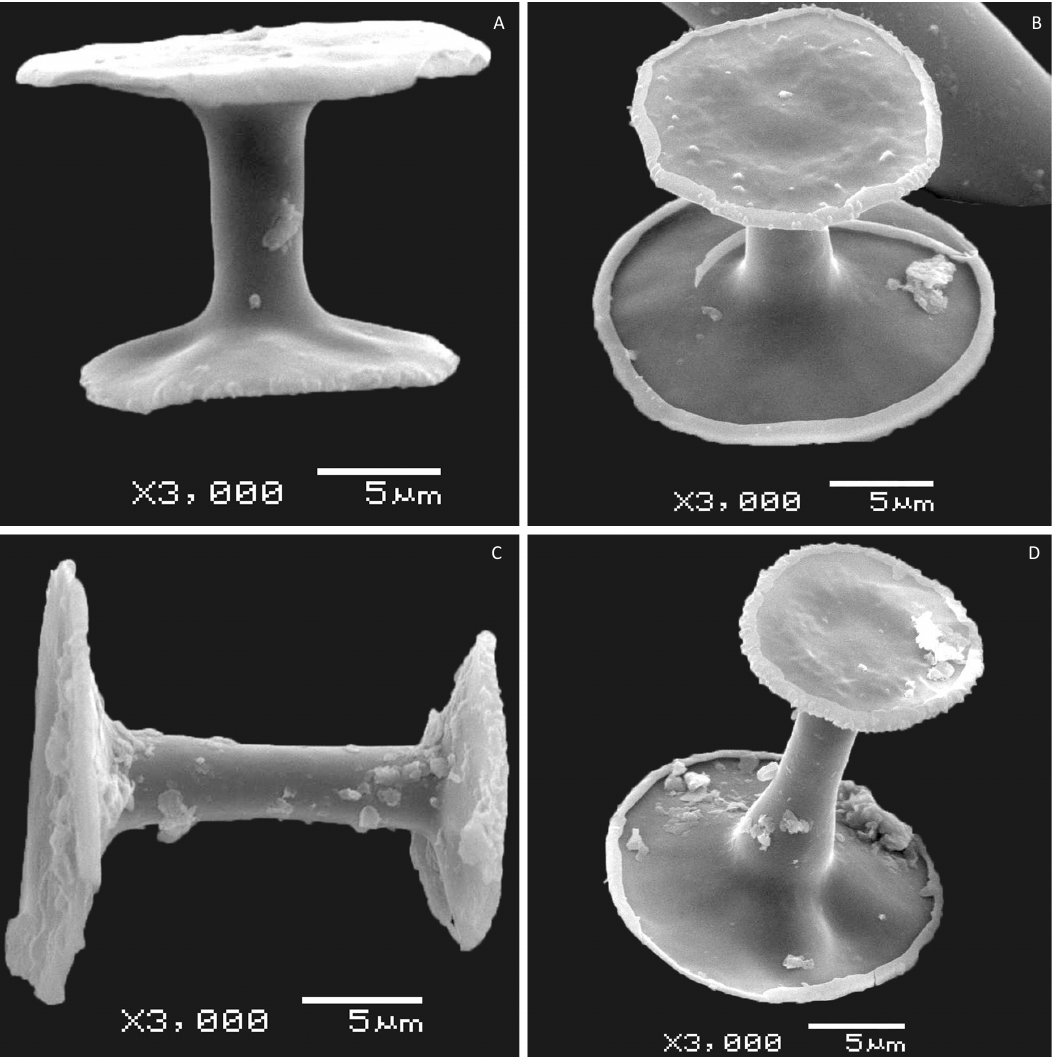
Image 3. Comparison of gemmuloscleres with SEM. A - Lateral view of gemmulosclere of T. latouchiana ; B - View at an angle of the gemmulosclere; C - Lateral view of gemmulosclere of T. latouchiana sinensis ; D - View at an angle of the gemmulosclere. Note spines on recurved margins. © H.V. Ghate, Shriraj S. Jakhalekar &